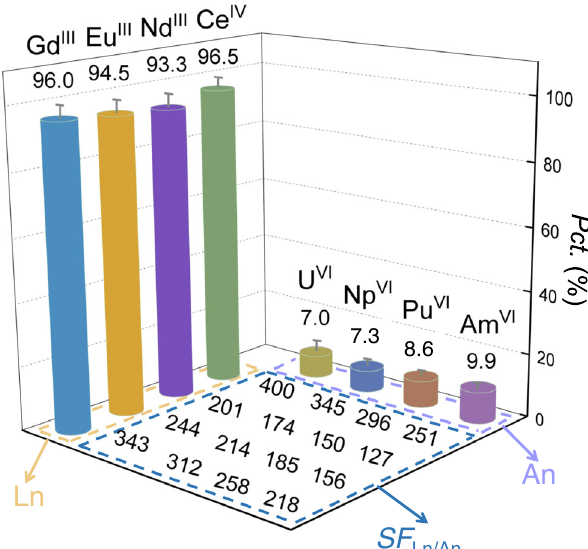
Fig.4|Separationresultsofamixedactinides/lanthanideswastesolutionafter sievingthroughtheGOM. ThesolutionconsistsU,Np,Pu,Am,Ce,Nd,Eu,andGd in 3.0M HNO 3 (detailed compositions of the solution are provided in Supple- mentary Table 2); sieving time: 24h. All the error bars represent the standard deviation of the